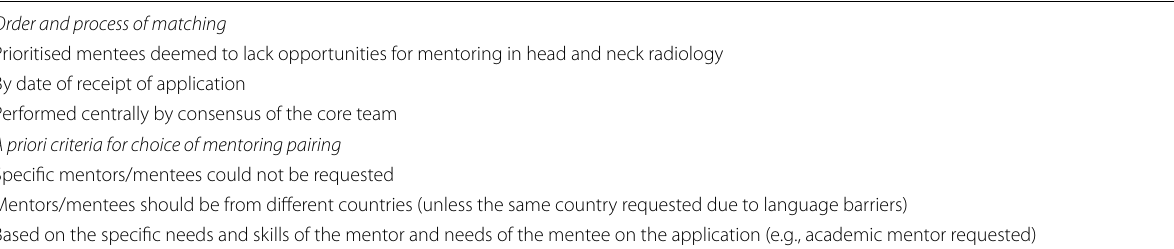
Table 2 Criteria for matching of mentors/mentees Order and process of matching Prioritised mentees deemed to lack opportunities for mentoring in head and neck